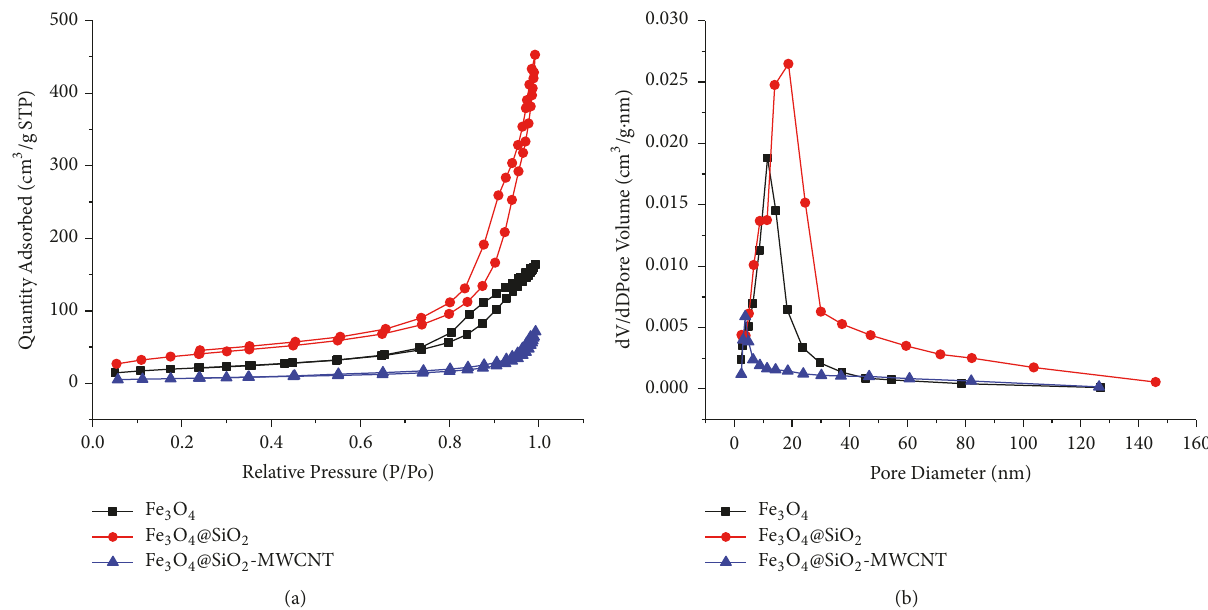
Figure 3: Panel (a) is the nitrogen adsorption-desorption isotherm for Fe 3 O 4 @SiO 2 -MWCNT, and panel (b) is the corresponding